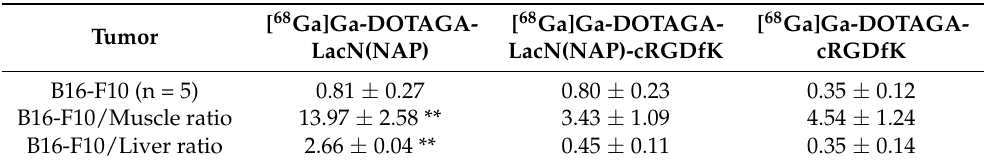
Table 1. Ex vivo assessment of the uptake of 68 Ga-labeled DOTAGA-LacN(NAP), DOTAGA- LacN(NAP)-cRGDfK, and DOTAGA-cRGDfK in experimental subcutaneous B16-F10 tumors 100 min postinjection of the radiopharmaceutical and 10 ± 1 days following tumor cell transplantation. %ID/g tissue values are expressed as mean ± SD. Level of significance (between the T/M and T/L ratios of [ 68 Ga]Ga-DOTAGA-LacN(NAP) and the two other radiotracers): p ≤ 0.01 (**).T/M: SUVmean of tumor/SUVmean of muscle. T/L: SUVmean of tumor/SUVmean of liver.